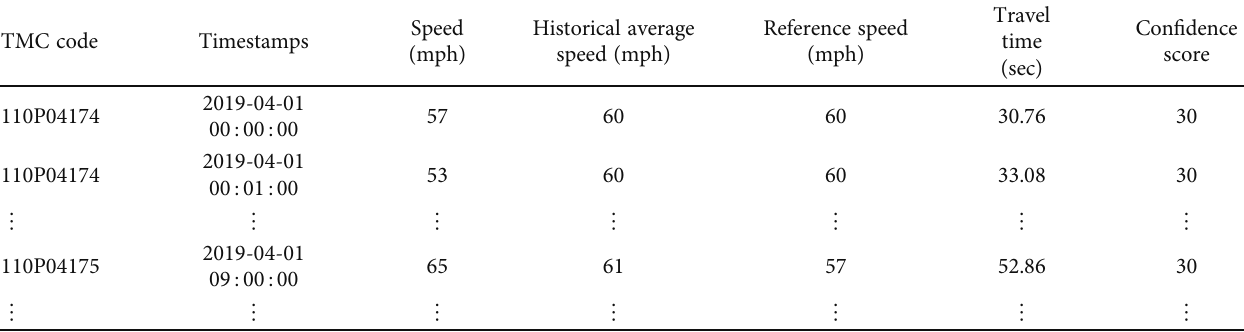
Table 1: Tra ffi c data format.